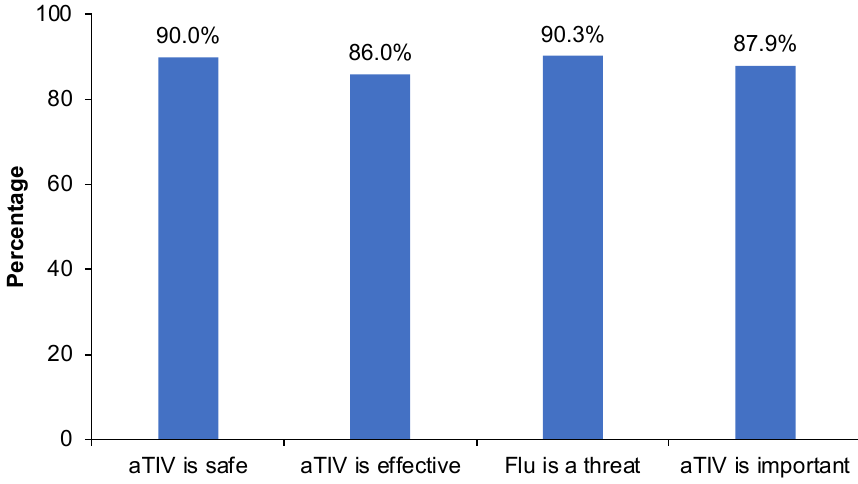
Figure 3. Parental beliefs about aTIV as a function of publicly funded and not publicly funded vac ‐ cine status, shown as the percentage of parents responding “strongly agree” or “moderately